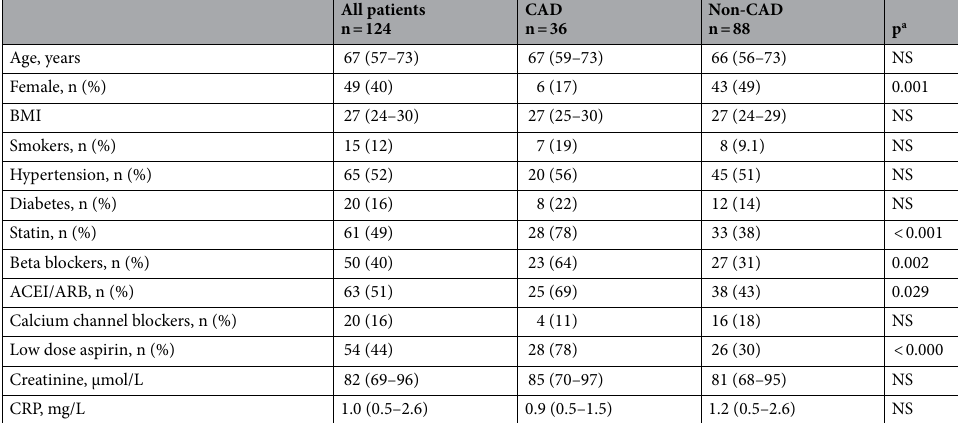
Table 1. Demographic and clinical characteristics, including medication and laboratory variables, of all patients and patients divided into two subgroups: those with documented CAD, defined as a history of prior MI and/or coronary revascularization and/or a myocardial perfusion deficit, and those with no signs of CAD, i.e. no history of prior CAD events and normal SPECT MPI (non-CAD). a CAD vs non-CAD. BMI, body mass index; ACEI/ARB, angiotensin converting enzyme inhibitors/angiotensin receptor blockers; CRP, C-reactive protein.